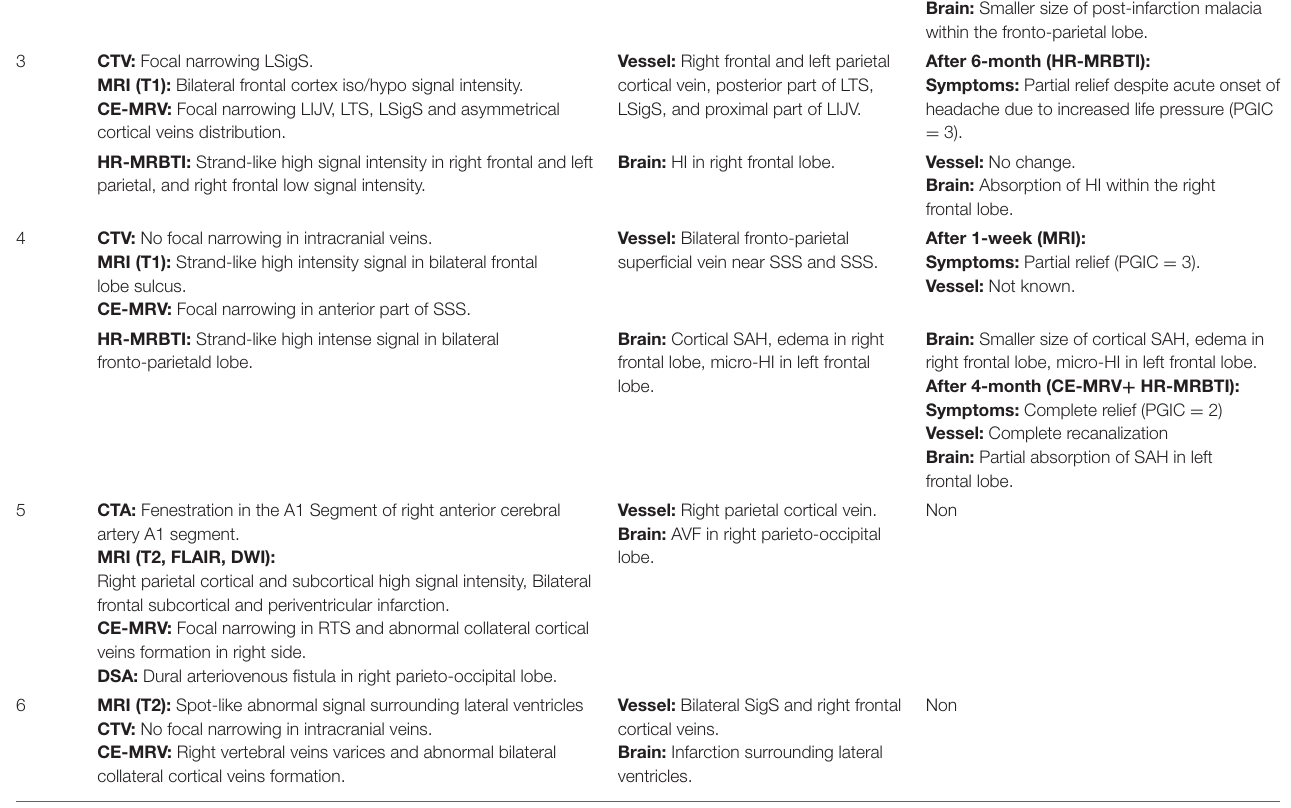
Brain: Infarction surrounding lateral